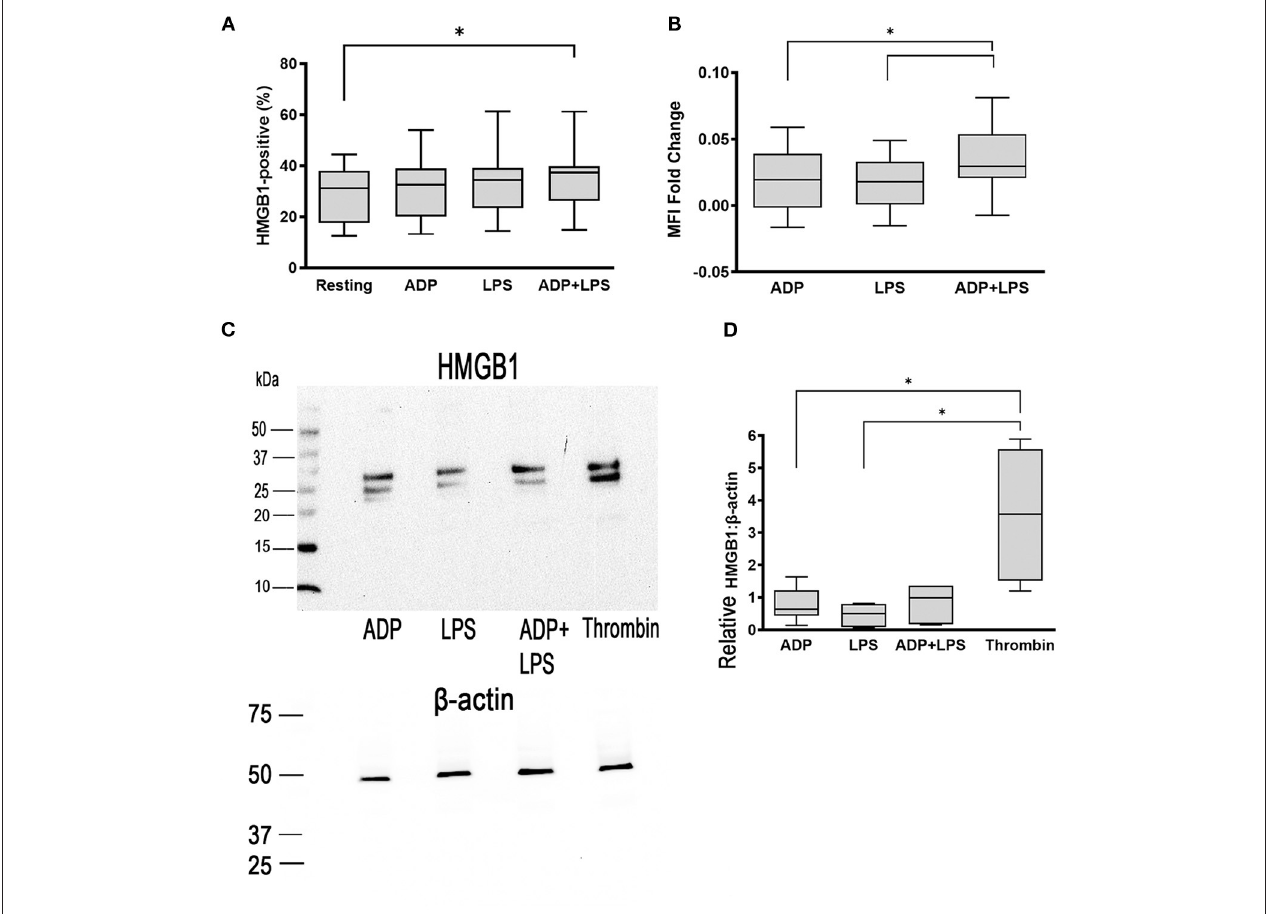
FIGURE 2 | ADP priming in the presence of LPS upregulates surface HMGB1 expression. Washed platelets from 8 dogs were unstimulated (resting) or activated with 5 µ g/ml LPS or 10 µ M ADP. Platelets were also primed with 10 µ M ADP prior to treatment with LPS. (A,B) Surface HMGB1 expression from 8 dogs was assessed by flow cytometry and measured as percent (%) positive or median fluorescence intensity (MFI) fold change on a log 10 scale. While LPS alone did not augment surface HMGB1 expression, LPS in the presence of ADP upregulated HMGB1 expression. (C,D) Total cellular HMGB1 expression in 1 × 10 8 platelets/ml was further assessed by western blot and relative densitometry calculated based on beta-actin, used as loading control in 6 dogs with 2 replicates in each dog with identical results. (C) Representative immunoblot of HMGB1 ( ∼ 25–29 kDa) and β -actin ( ∼ 42 kDa) in platelet lysate after stimulation with 10 µ M ADP, 5 µ g/ml LPS or LPS in the presence of ADP. Thrombin (0.01 U/ml) served as positive control. LPS alone or LPS in the presence of ADP did not upregulate total cellular HMGB1 expression. Each box represented the 25th and 75th quartiles and line represents the median. Whiskers represent the range of data. * p > 0.05. One-way repeated measures